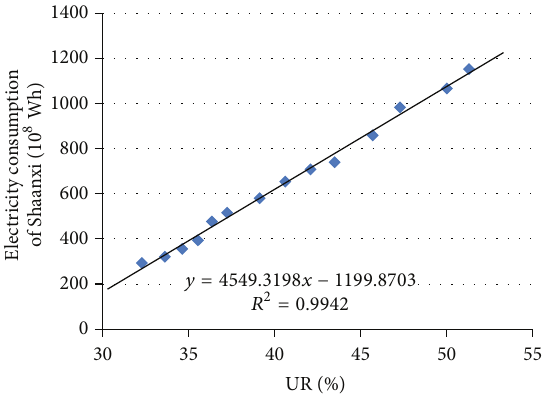
Figure 5: Unary linear regression result of model